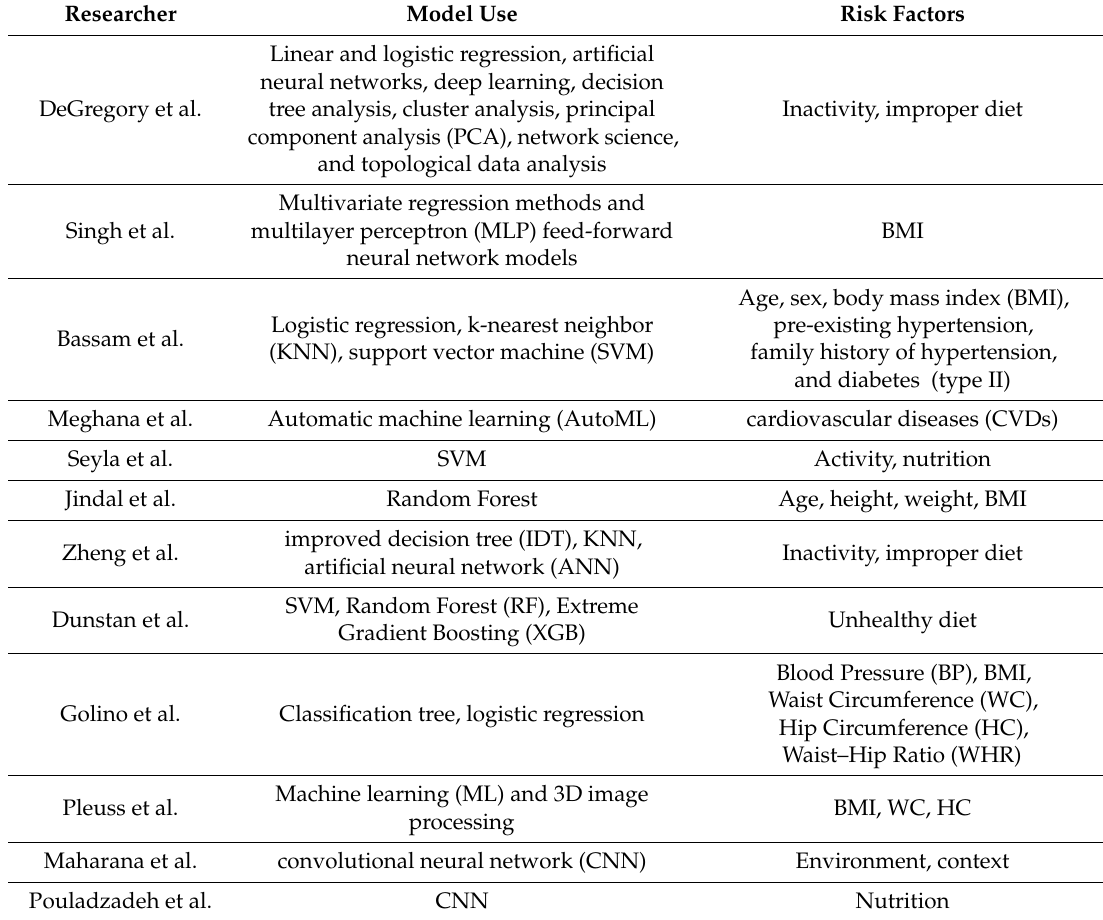
Table 2. AI models and the risk factors related to obesity /